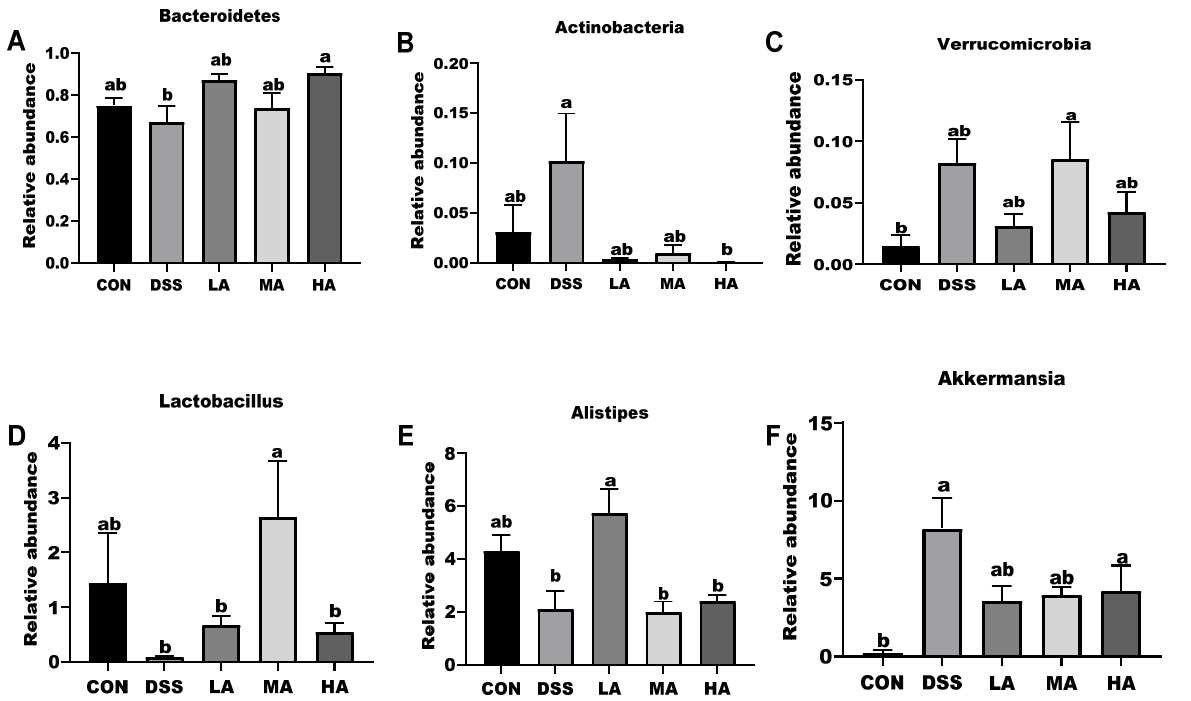
Figure 7. The 16S rRNA bacterial sequences represented in colons. ( A ) The relative abundance of Bacteroidetes at the phylum. ( B ) The relative abundance of Actinobacteria at the phylum. ( C ) The relative abundance of Verrucomicrobia at the phylum. ( D ) The relative abundance of Lactobacillus at the genus. ( E ) The relative abundance of Alistipes at the genus. ( F ) The relative abundance of Akkermansia at the genus. Values are expressed as mean ± SEM, n = 6. a, b Mean values with different small letter superscripts mean a significant difference ( p < 0.05).